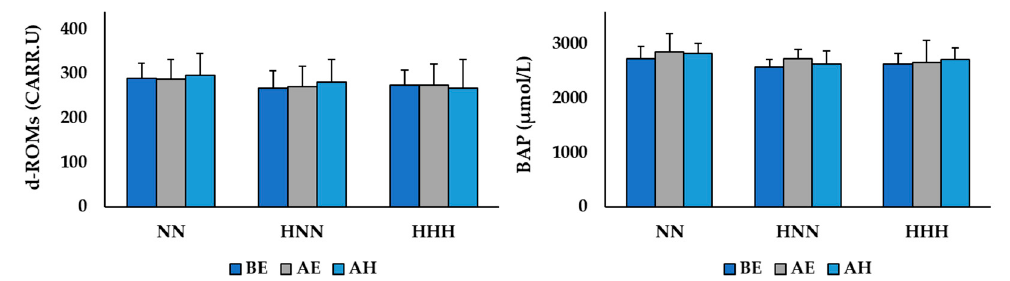
Figure 3. Changes in oxidative/antioxidant balance markers according to HBOT after exercise in NN and HH environments. Values are mean ± standard deviation; NN: exercised in normobaric, normoxic conditions; HNN: HBOT treatment after exercising in normobaric, normoxic conditions; HHH: HBOT treatment after exercising in in hypobaric, hypoxic conditions; BE: before exercise; AE: after exercise; AH: after HBOT d-ROMs: derivatives of reactive oxygen metabolites; BAP: biological antioxidant